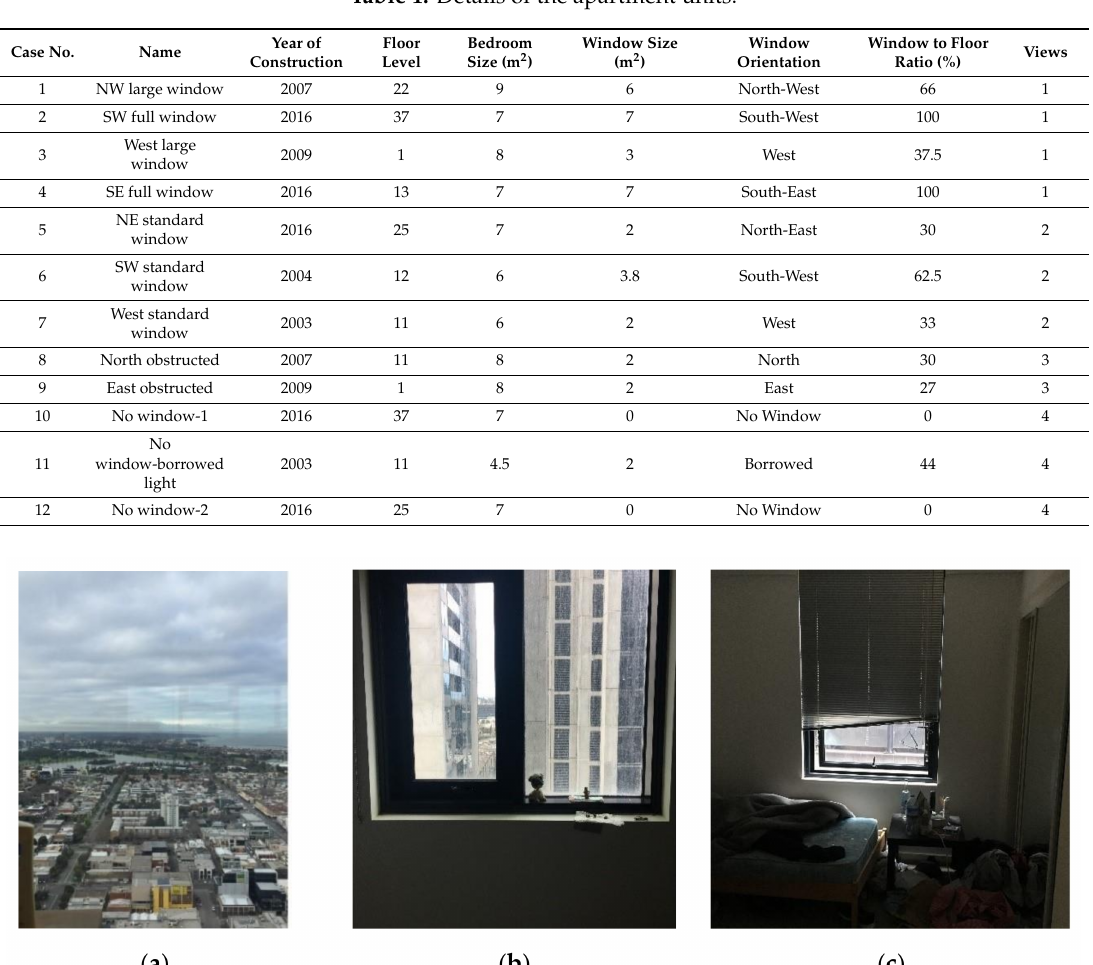
Figure 4. View from the bedroom: ( a ) pleasant ( b ) standard ( c )